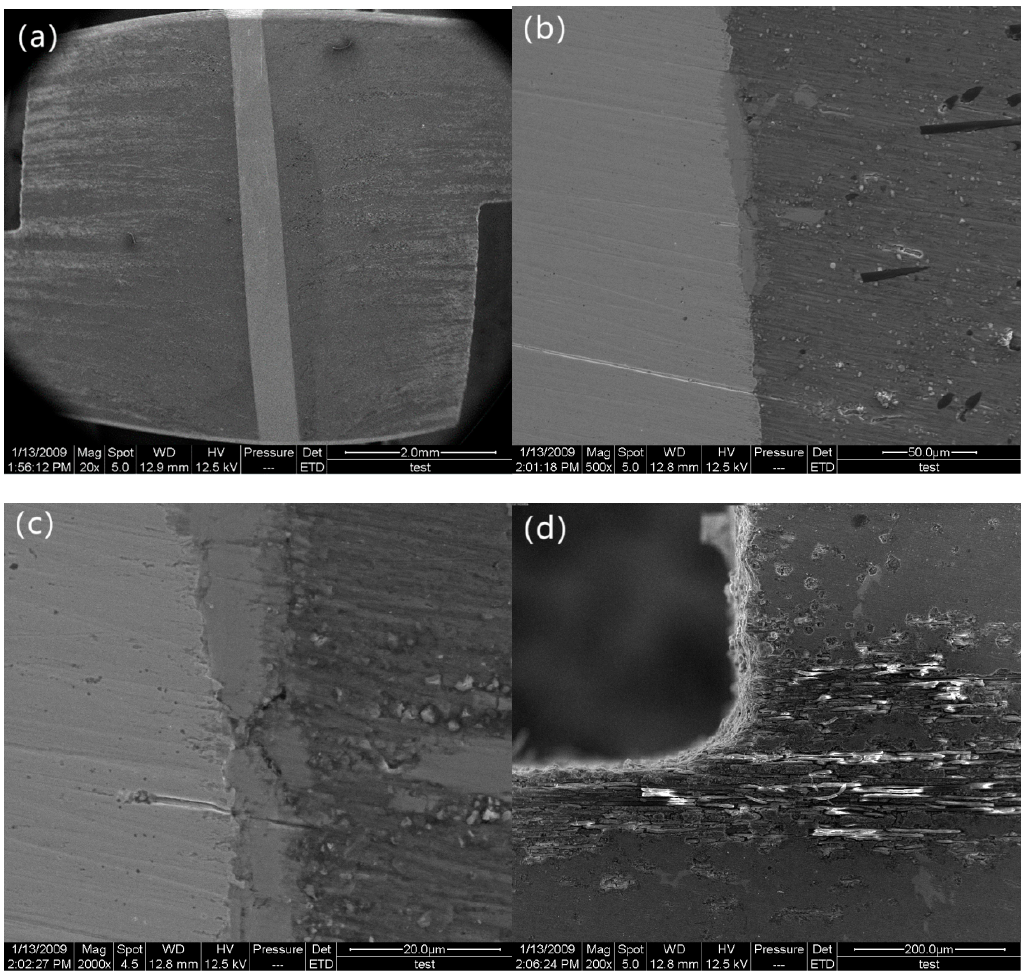
Figure 3. Morphology of the specimen prior to test: ( a ) the z-pin, ( b ) the z-pin/matrix interface in low magnification, ( c ) the z-pin/matrix interface in high magnification, and ( d ) the notch.